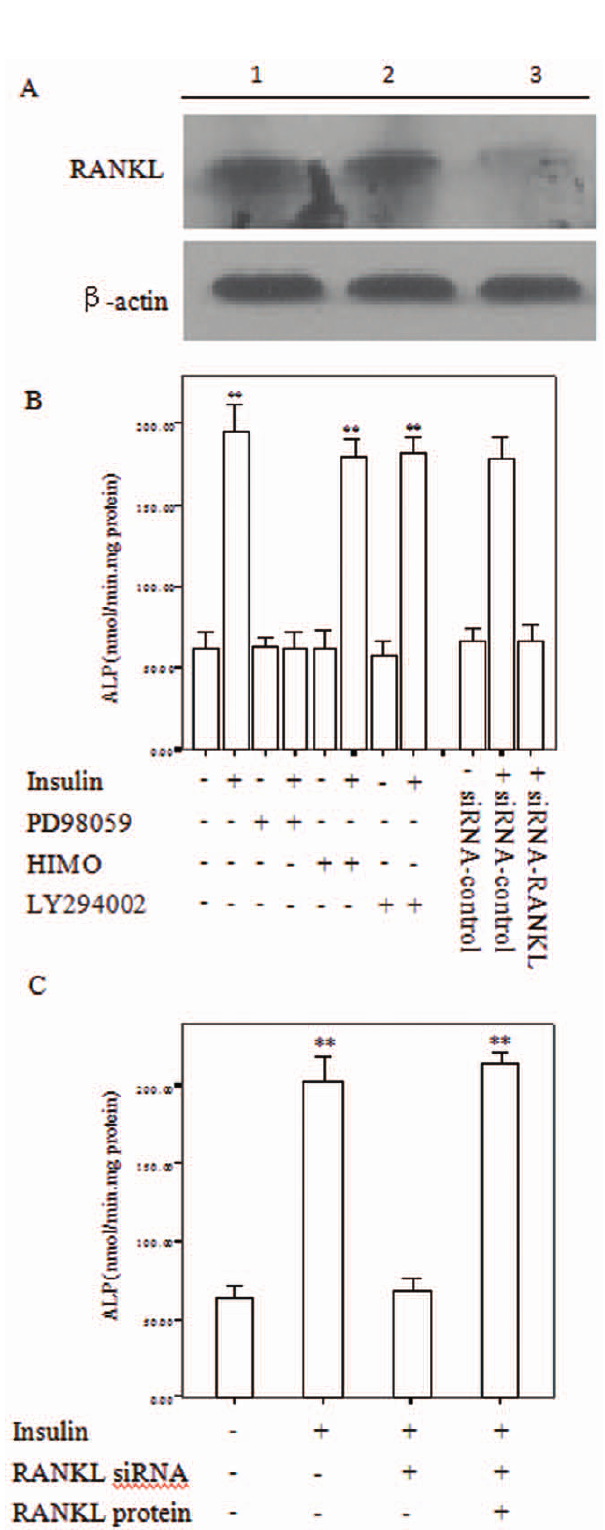
Figure 4. Insulin-promoted osteoblastic differentiation of calcifying vascular smooth muscle cells (CVSMCs) through the ERK1/2/RANKL signaling pathway. (A) Treatment with siRNA- RANKL blocked the expression of RANKL protein in osteoblasts. Cells were treated with siRNA control, or siRNA-RANKL. Total cellular protein was subjected to immunoblot analysis using anti-RANKL antibody. Lane 1, lysate from CVSMCs; lane 2, lysate from CVSMCs treated with siRNA control; lane 3, lysate from CVSMCs treated with siRNA-RANKL. (B)